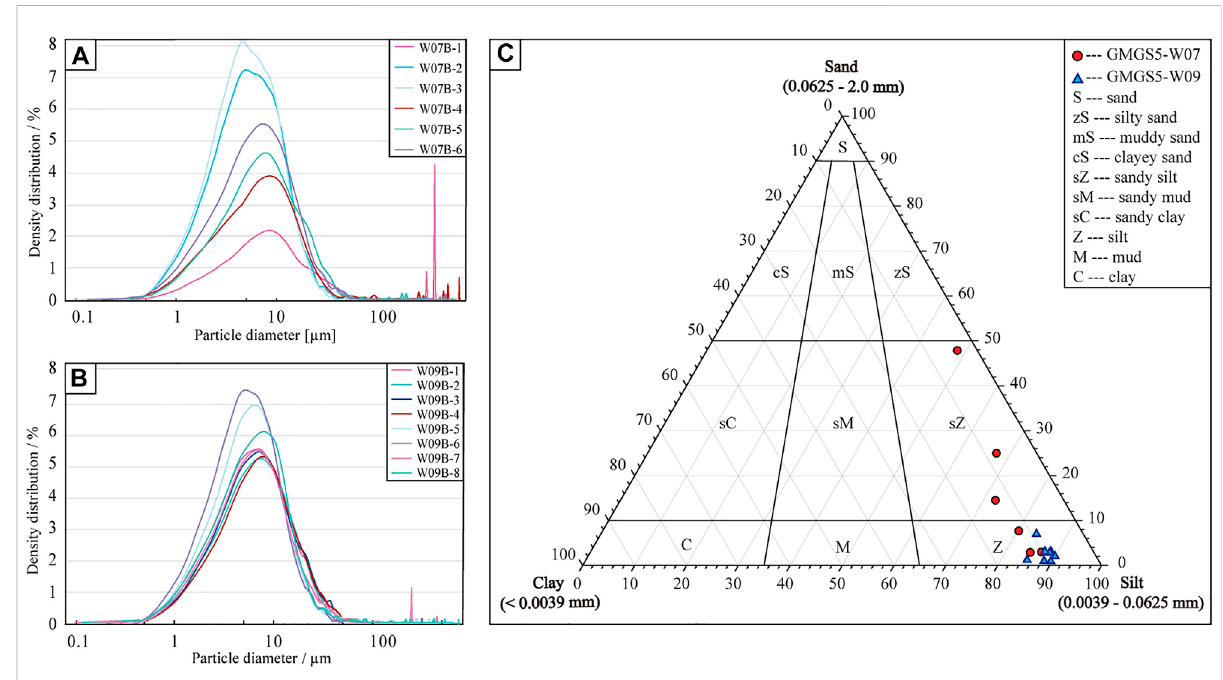
FIGURE 2 Sediment particle size analysis results of site W07 and W09. (A,B) show the particle size distribution, density distribution based on volume, and particle diameter calculated by the particle projection. (C) shows the textural classi fi cation of the samples based on Folk et al.